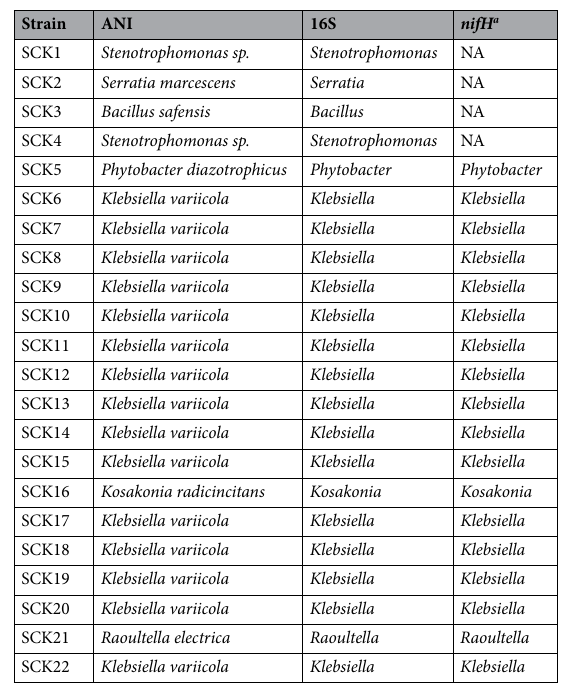
Table 2. Identity of the most closely related species (genus) for the isolates characterized here. Species (genus) identification was performed using average nucleotide identity (ANI), 16S rRNA and nifH sequence comparisons. a NA—not applicable, since these isolates do not encode nifH